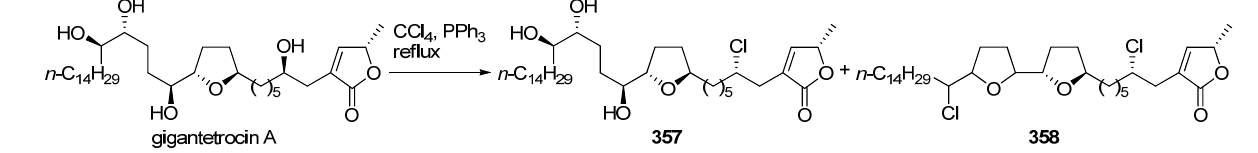
Table 26. Bioactivity data of chlorinated analogues 357 – 358 (LC